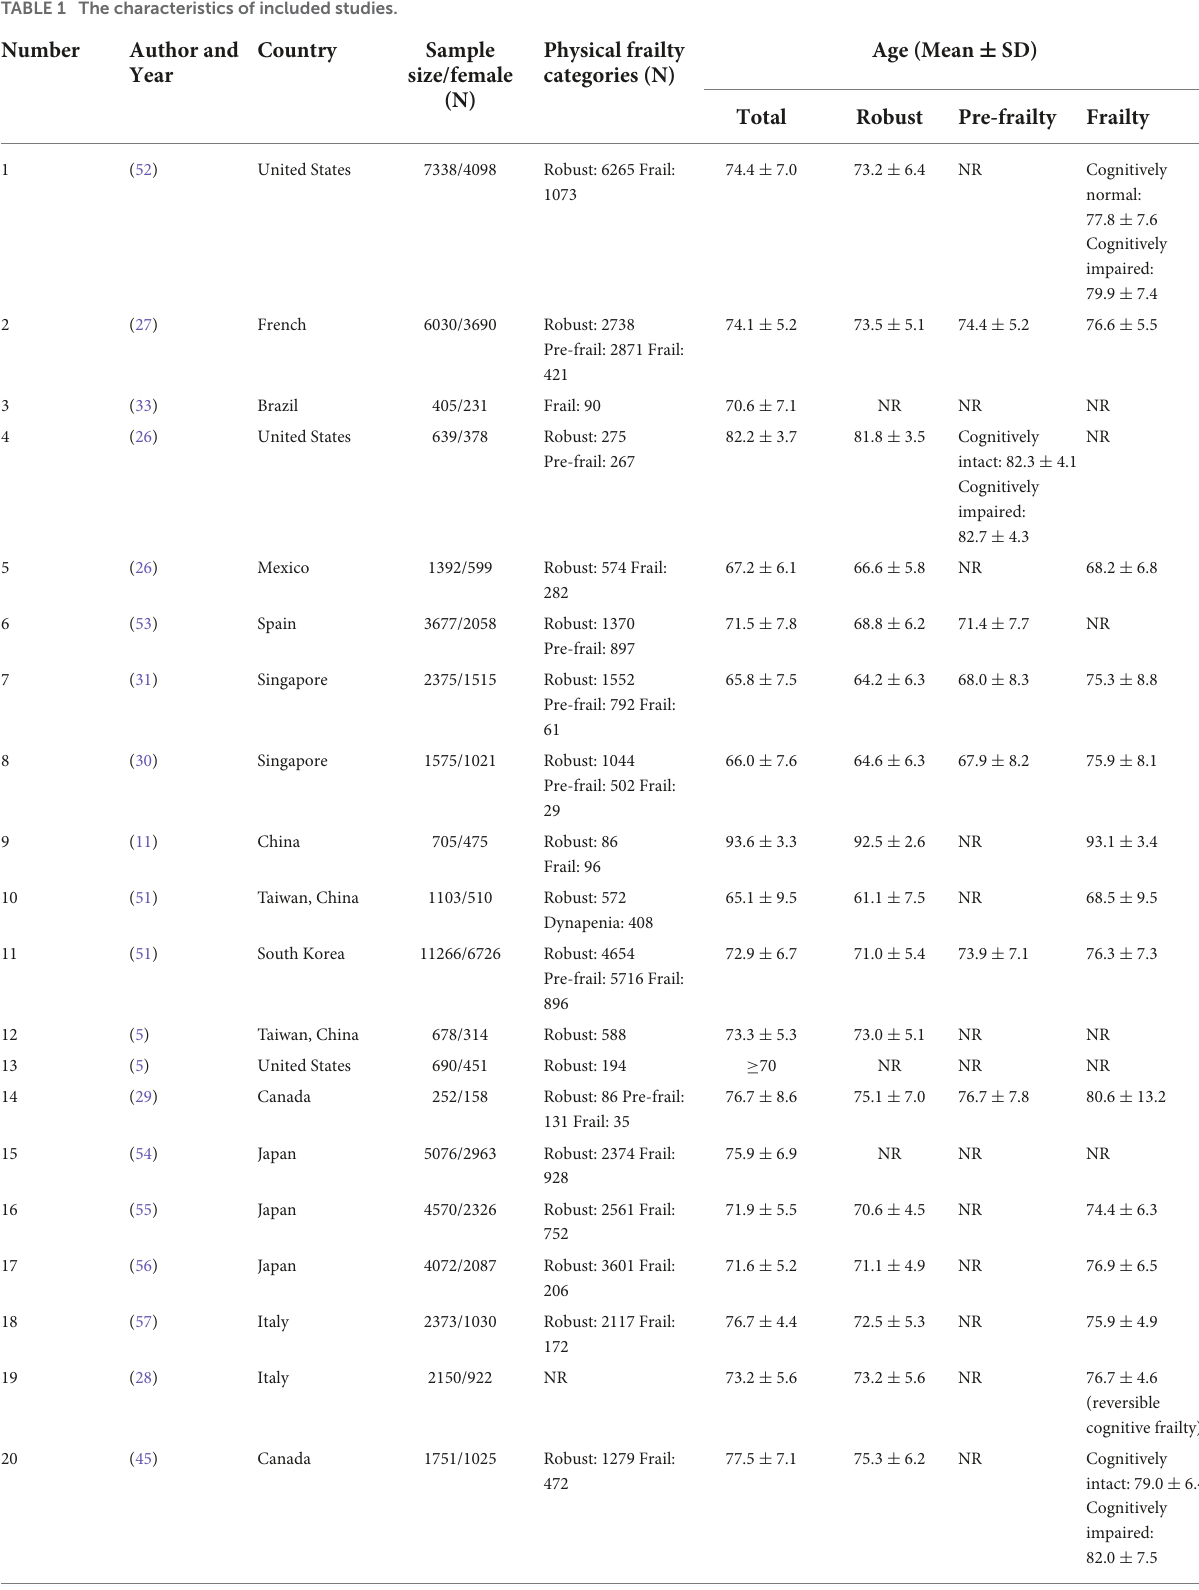
TABLE 1 The characteristics of included